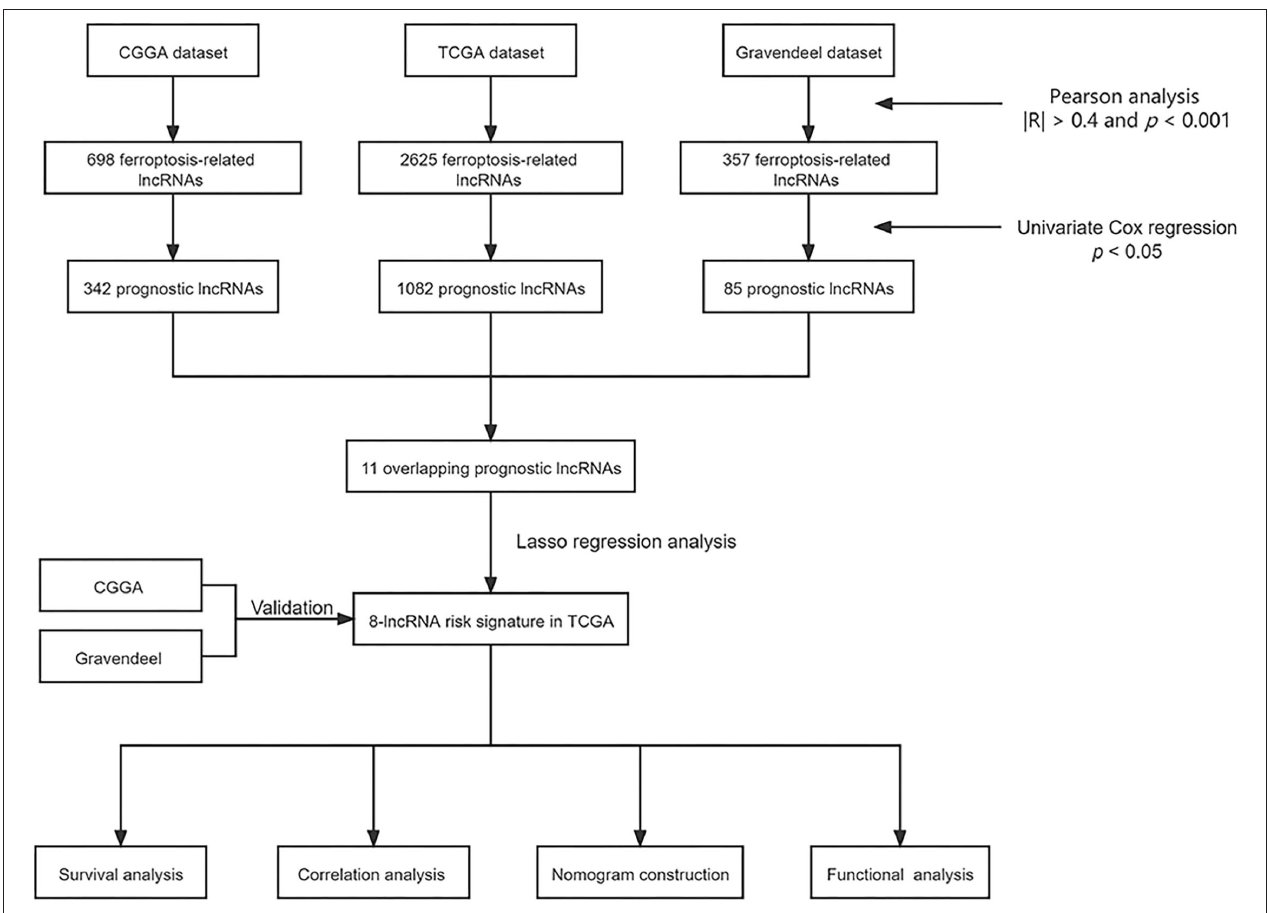
FIGURE 1 | The flow chart of our